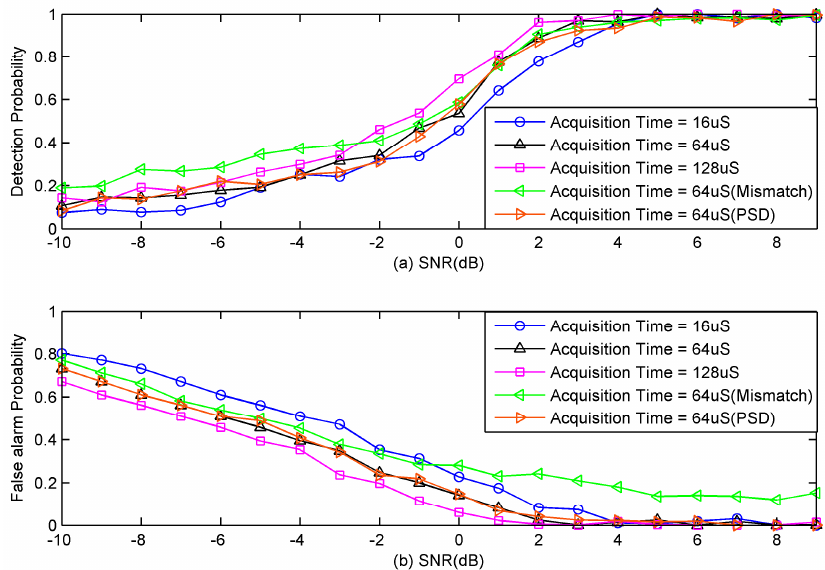
Figure 7. Influence of acquisition time on spectrum-sensing performance. ( a ) Detection probability. ( b ) False alarm probability.